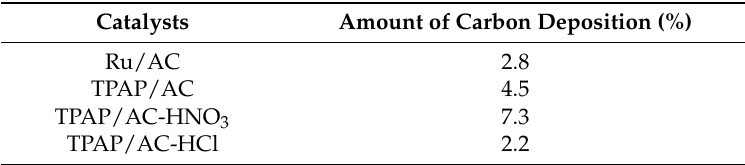
Figure 3. TG (Thermogravimetric) curves of the fresh and spent TPAP/AC ‐ HCl catalysts. Table 2. The amount of coke deposition on the Ru ‐ based catalysts.